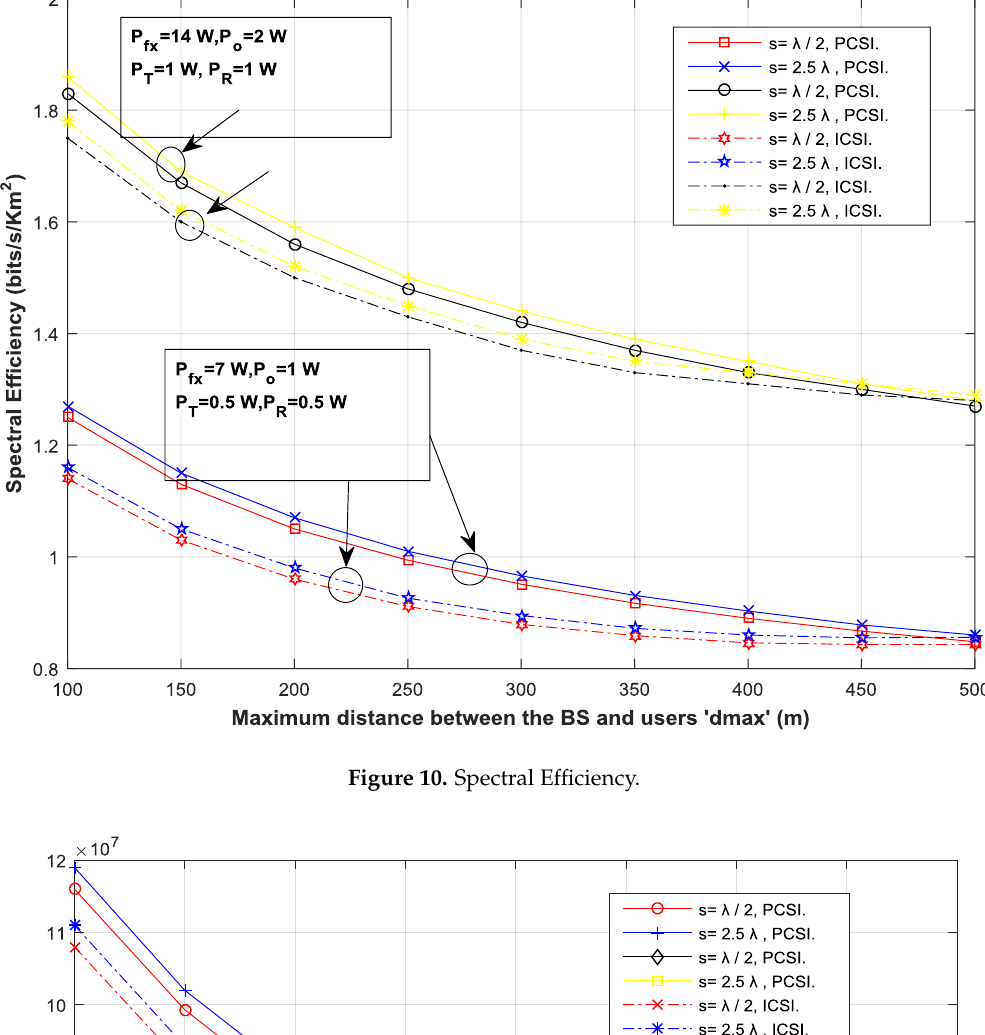
Figure 10. Spectral Efficiency.